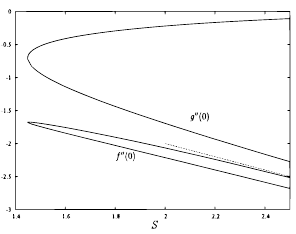
Figure 6. Permeable surface, S (cid:54) = 0: plots of f (cid:48)(cid:48) (0) and g (cid:48)(cid:48) (0) against S for γ = − 1 obtained from the numerical solution to equations (2.4)–(2.6), (2.8). Asymptotic expression (4.7), for S large, is shown by the broken